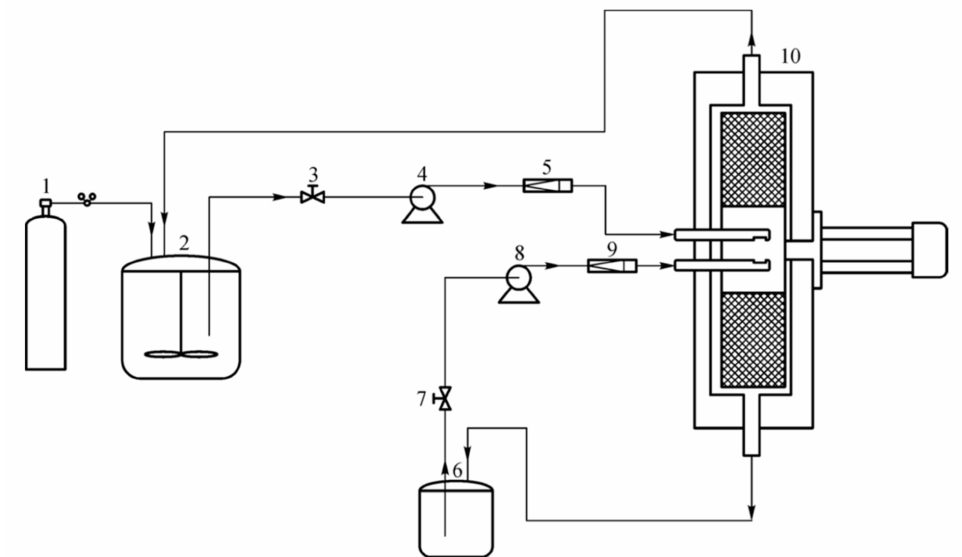
Figure 5. Schematic diagram of experimental setup for waterborne polyurethane (WPU) emulsification. 1: Nitrogen cylinder; 2: pre-polymerization reactor; 3, 7: valve; 4, 8: pump; 5, 9: flow meter; 6: emulsion storage tank; 10: RPB [36]. Copyright © (2020) Higher Education Press.